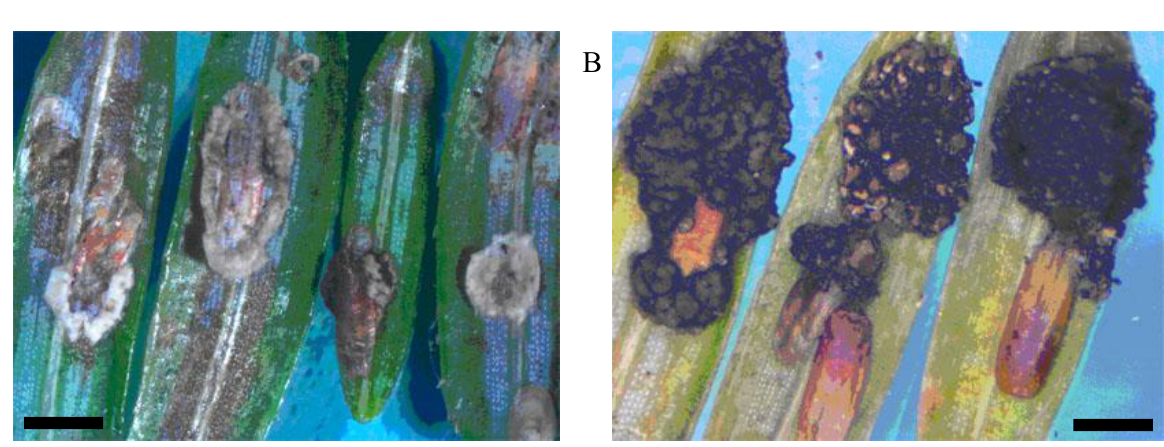
Figure 1. Elongate hemlock scale mycosis caused by Myriangium duriaei before ( A ) and after ( B ) sclerotization. (Bars = 0.5 mm)